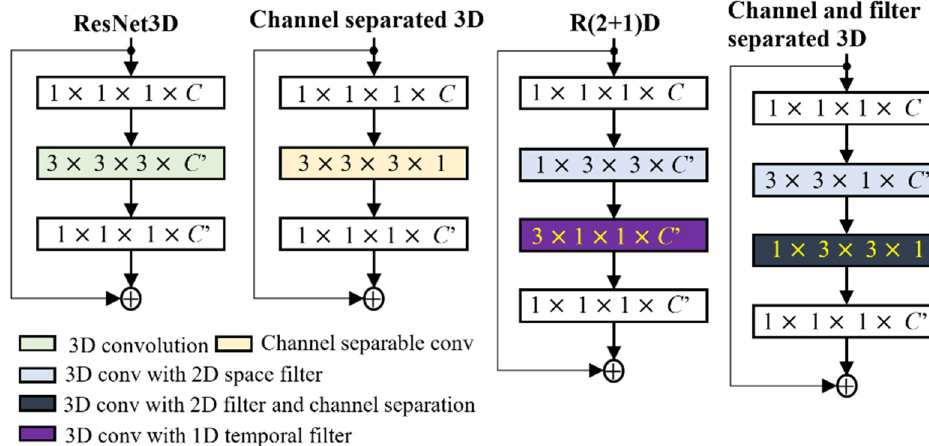
Sensors 2021 , 21 , x FOR PEER REVIEW Figure 2. The 3D convolution and its variants in the residual block representation.